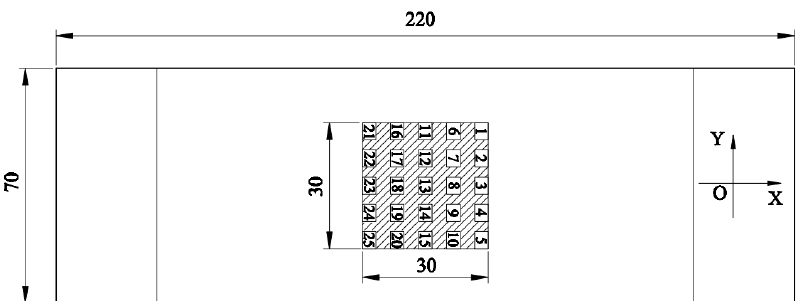
Figure 2. Shape and dimensions of the specimen (unit: mm). Figure 3 shows a block diagram of the measurement system. A DC external magnetic field and stress were applied to the specimen. The external magnetic field was provided by a U-shaped electromagnet (the core was formed by U-shaped Mumental laminations with magnetizing coils wound on the two poles; the number of turns of each coil was 500), the direction of the applied magnetic field could be changed by rotating the poles of the electromagnet in different directions to provide noncoaxial magnetic fields. The value of the external magnetic field was controlled by the current of the DC power supply. A material testing machine MTS with a peak capacity of 100 kN was used to load uniaxial tension. The change in the magnetization caused by the stress and magnetic field was detected using a magnetic array probe. The key parts of the array probe were 25 magnetic probes based on TMR2505 sensors (working voltage VDD = 5 V; magnetic field measurement ranges from plus to minus 200 Oe; sensitivity Sen = 2.2 mv/V/Gs within the range of ± 30 Oe; 1 Oe = 1 Gs in air = 0.1 mT = 79.8 A/m). The data were collected using a 16-bit resolution multi-channel magnetic field measurement system HB-1000 and processed by MATLAB